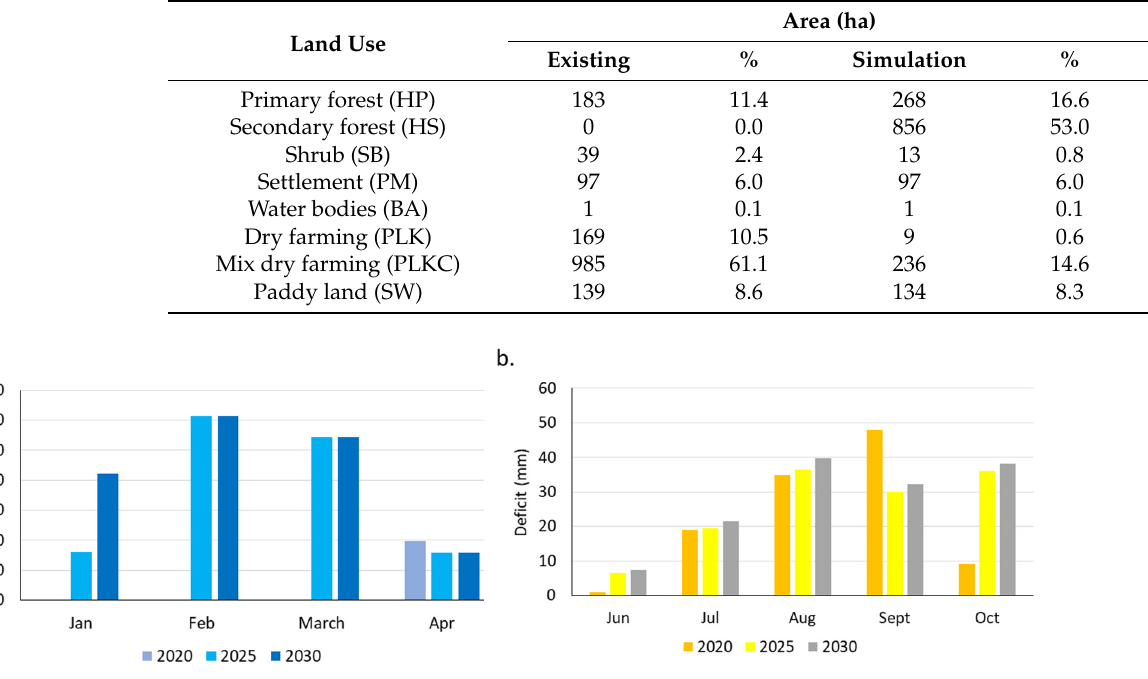
Table 1. Comparison of land use area on slopes > 25% in existing conditions and after simulation using scenario two.